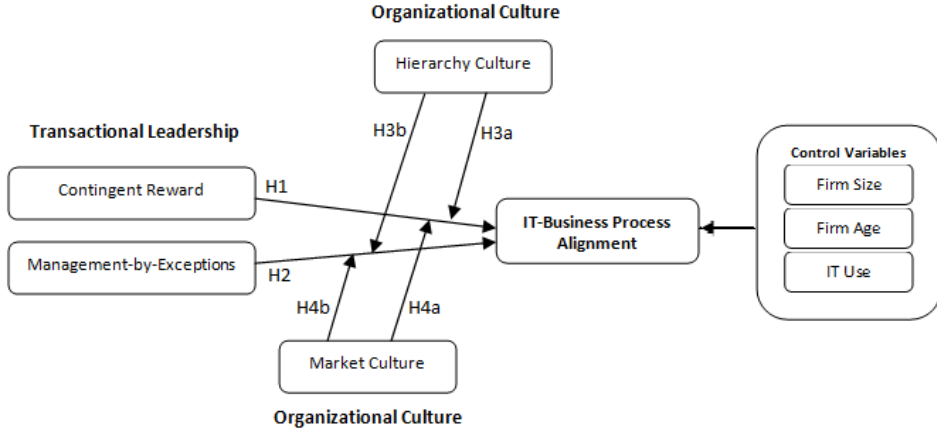
Figure 1. The impact mechanism of this study .